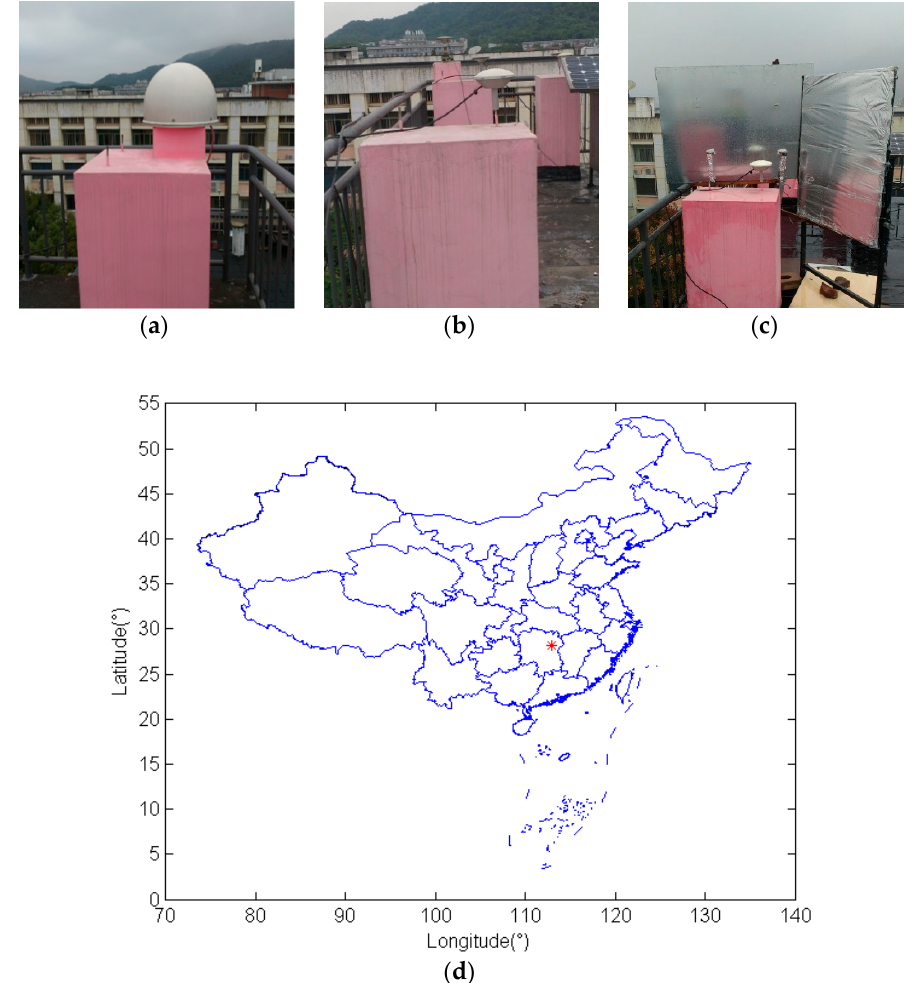
Figure 2. Photographs of the base station ( a ); the rover station in weak multipath environment ( b ); the rover station in multipath-rich environments ( c ); and the approximate location (28.170365° N, 112.925150° E, 69.705 m) of rover station on the map of China ( d ).